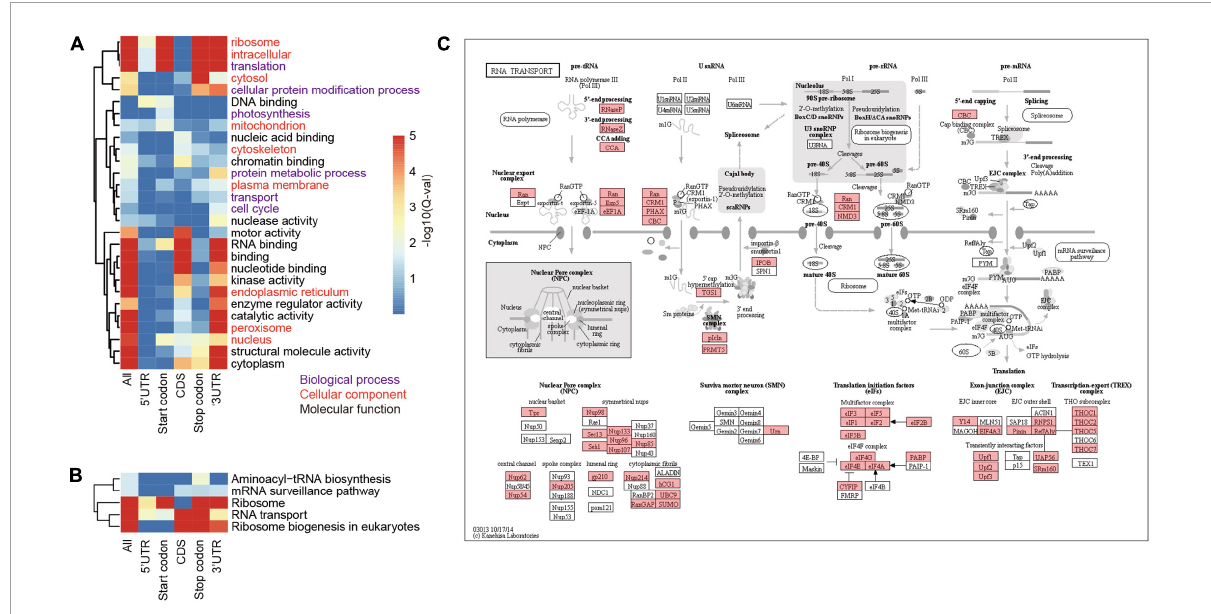
FIGURE4 Functional enrichment of proteins encoded by m6A-containing mRNAs. (A) GO terms enriched by proteins encoded by different groups of m6A-containing mRNAs. (B) The enriched pathways related to translation. (C) The KEGG map of “RNA transport,” in which the m6A-containing genes are shaded with